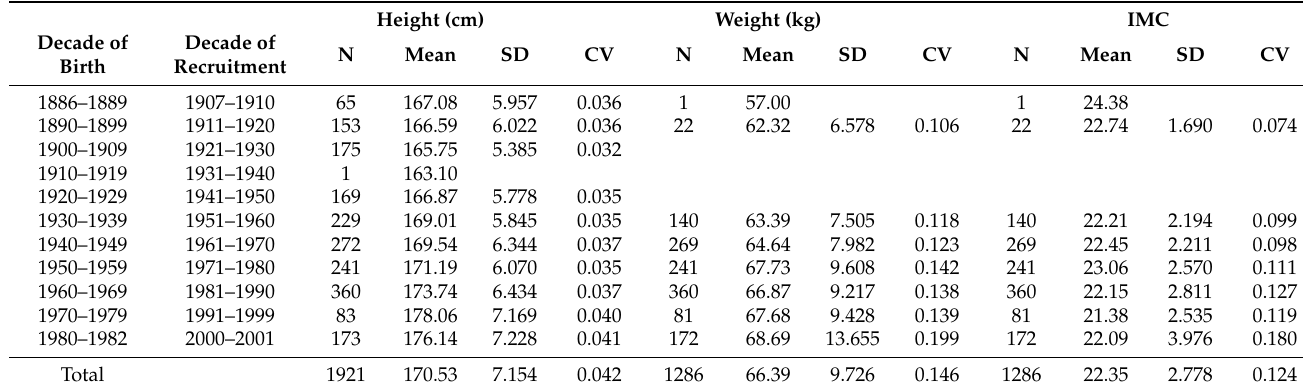
Table 2. Descriptive statistics by decade of birth/recruitment.